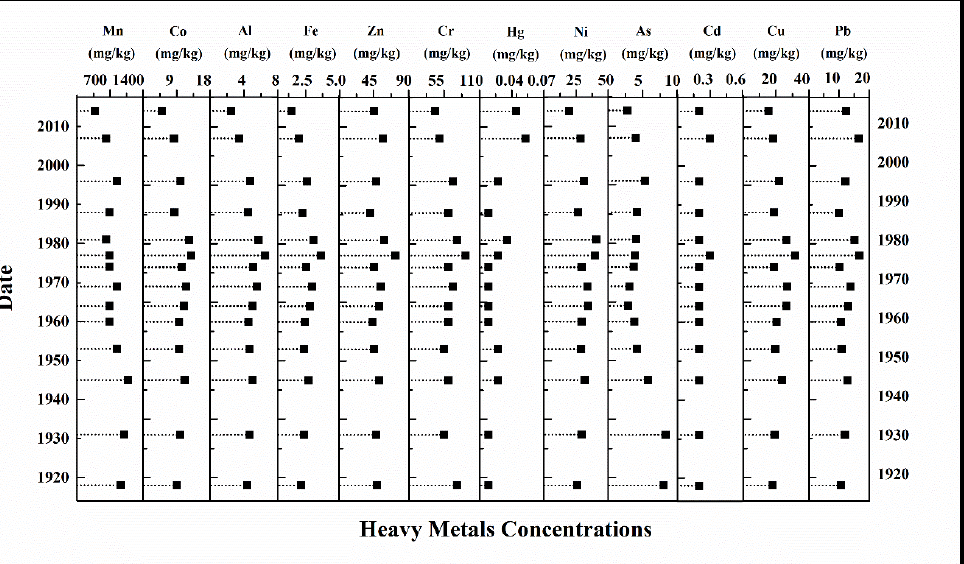
Figure 4. Temporal variation of heavy metals in sediment samples from Lacu Sărat Lake. Similar variation patterns can be observed for the following groups of elements: Cu-Pb, Zn-Cr-Ni-Hg, and Co-Al-Fe.